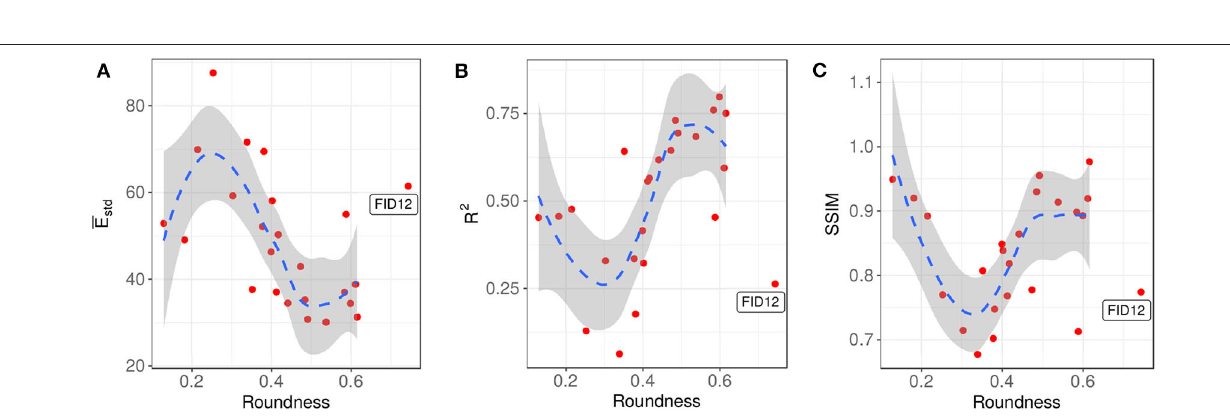
FIGURE 11 | Box plots for the assessment indices (A) ¯ 1 , ¯ E GC and ¯ E MD , (B) ¯ E mean , ¯ E mode , ¯ E max , and ¯ E std , and (C) ¯ α , ¯ β , R 2 and the SSIM. The normalization parameters are 2 R for the first group and h act mean for the second group.